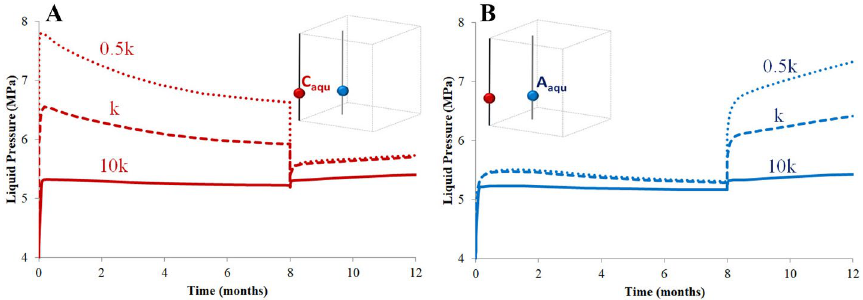
Fig. 18 Liquid pressures on the top of the aquifer for different intrinsic permeabilities (0.5 k, k and 10 k) in the aquifer: central well ( A ) and auxiliary well ( B )